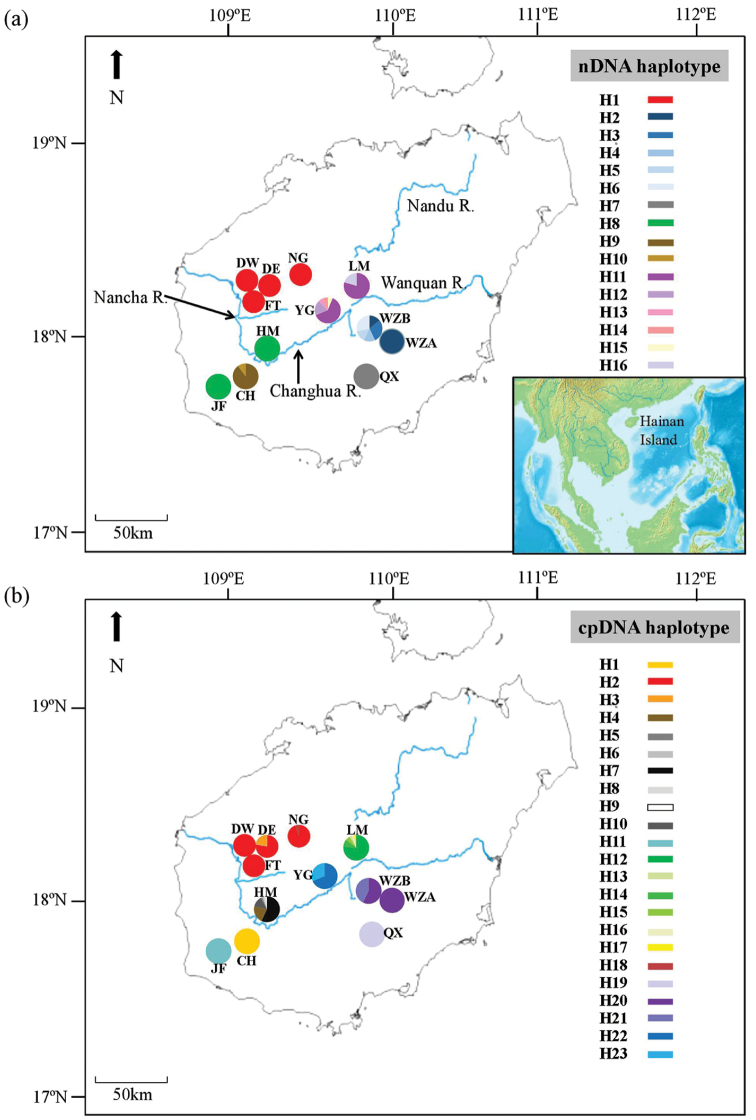
Sampling sites and nucleotype and haplotype distribution of nuclear ITS (a) and cpDNAtrnL-F and ycf1b (b) of Oreocharis lineages in Hainan Island.